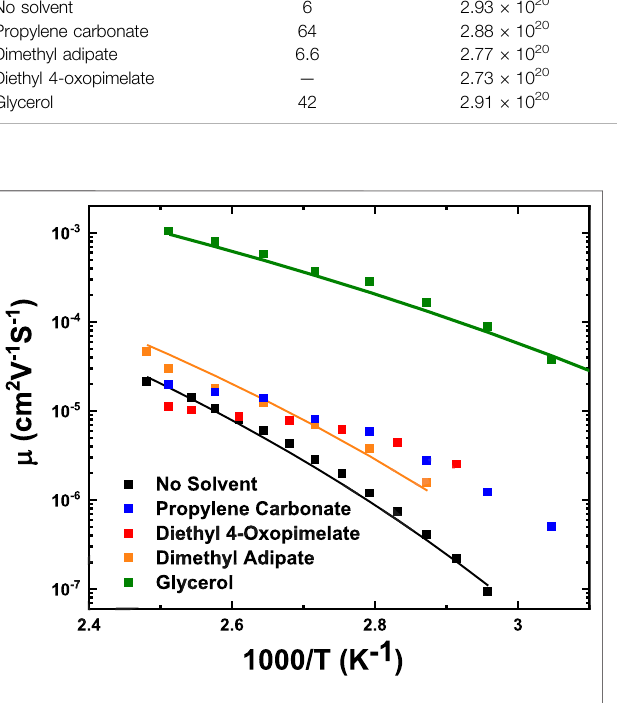
FIGURE 8 | Mobility of conducting ions as a function of temperature calculatedfromEq.6.Solidlinesare fi tstoVogel-Fulcher-Tammannequation, with fi tting parameters T 0 , D, and µ ∞ listed in Table 4 .